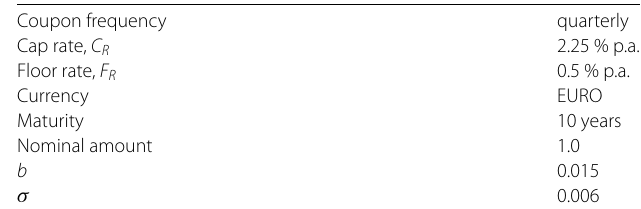
Table 3 Numerical Example of a floater with cap and